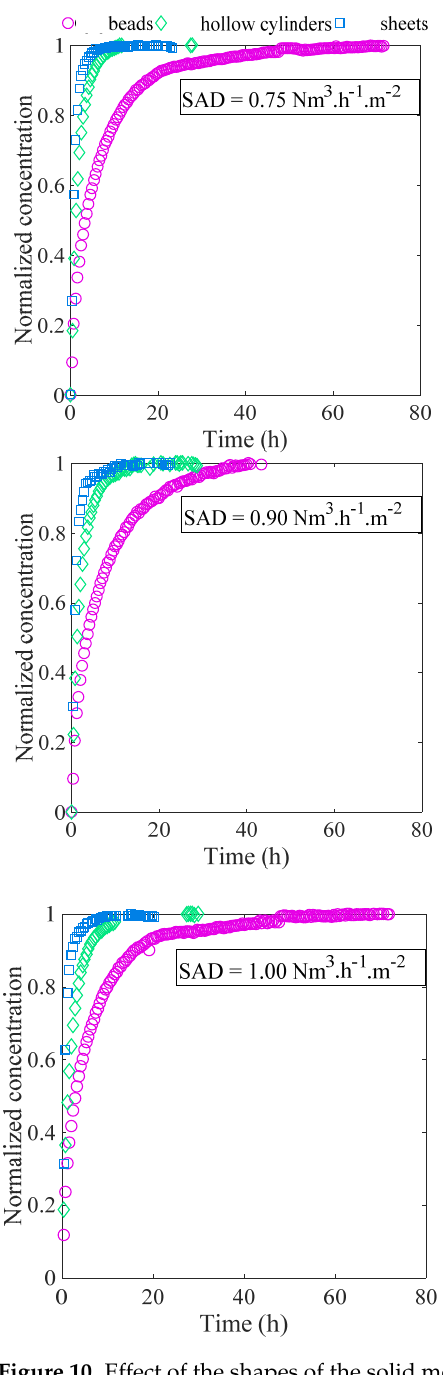
Figure 10. Effect of the shapes of the solid media on the normalized concentrations of Rose Bengal lactone in the liquid phase, for the three different air flowrates. ALMBR experiments. The effect of the media shapes can be determined, first, by visualizing the curves, since it appears clearly that the overall dynamics were faster for the sheets than for the hollow cylinders or the beads. This can be confirmed by the comparison of the times, t (cid:2915) , necessary to reach 96% of the equilibrium. It appears that the time to reach equilibrium for the beads was approximately three times greater than that for the hollow cylinders,